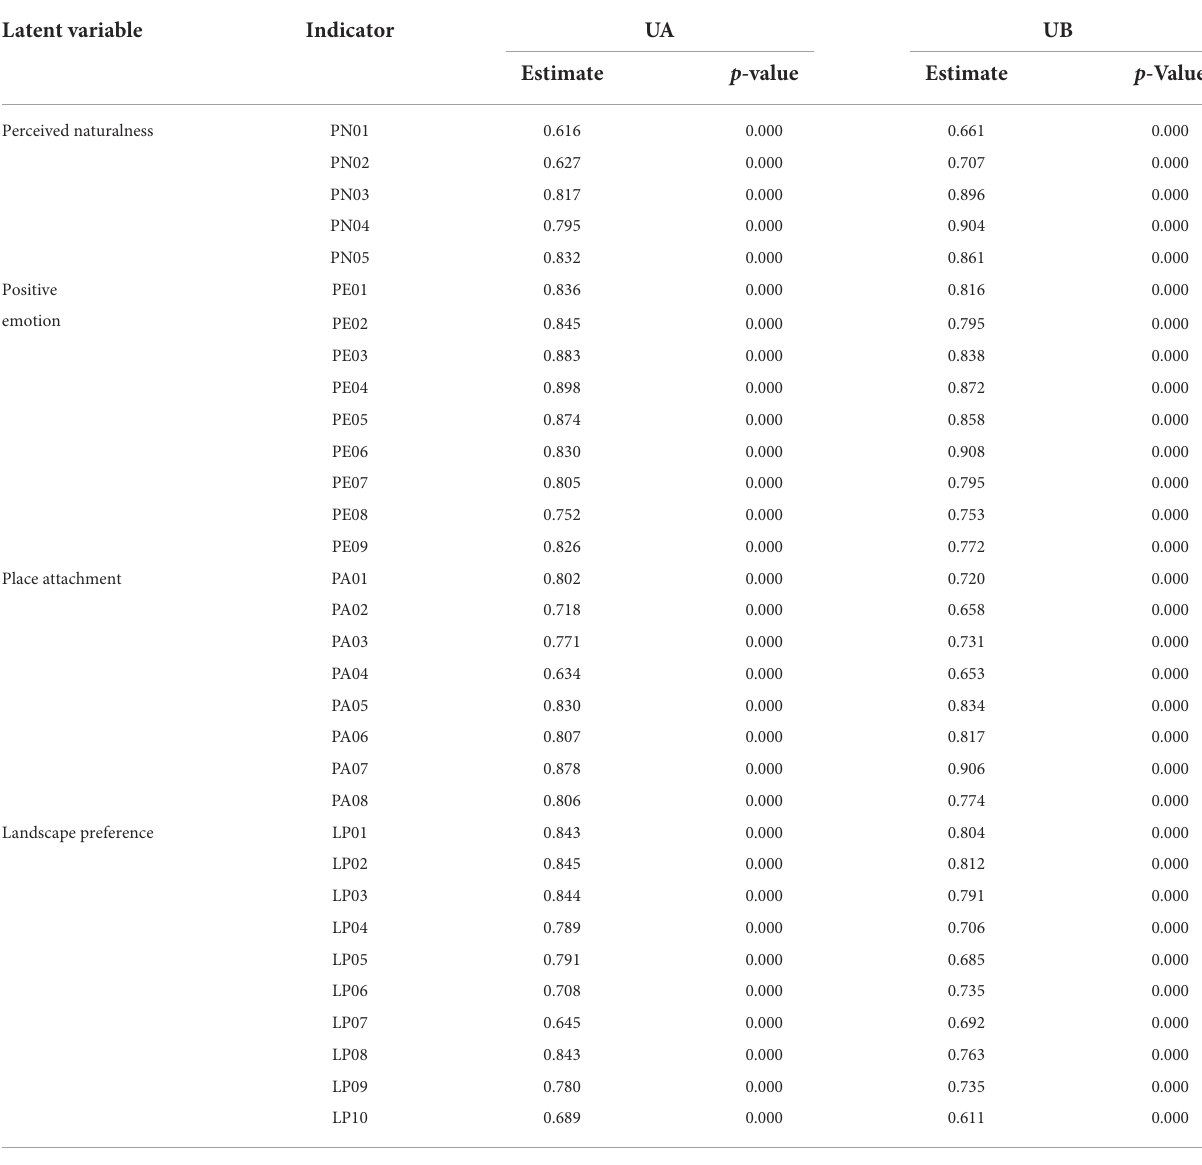
TABLE 5 Results of the measurement model.